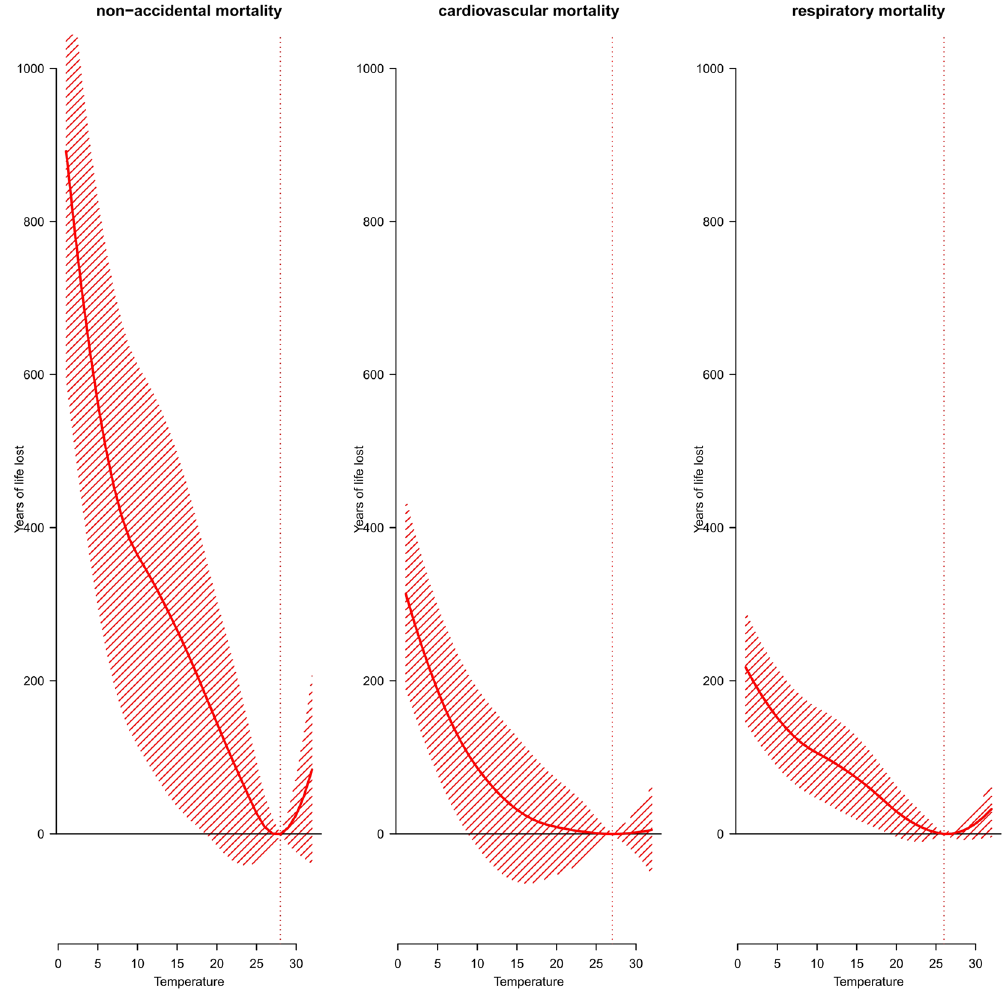
Figure 1. Overall cumulative exposure-response curves for the associations between temperature and years of life lost due to cause-specific mortality (non-accidental mortality, cardiovascular mortality, respiratory mortality) with 95% confidence intervals. The vertical lines represent the percentile of the minimum mortality temperature